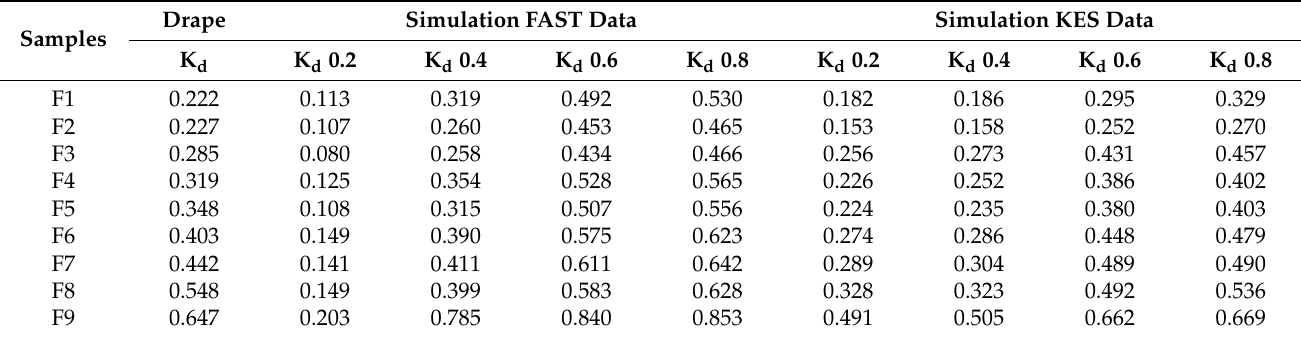
Table 6. Values of drape coefficients of simulated